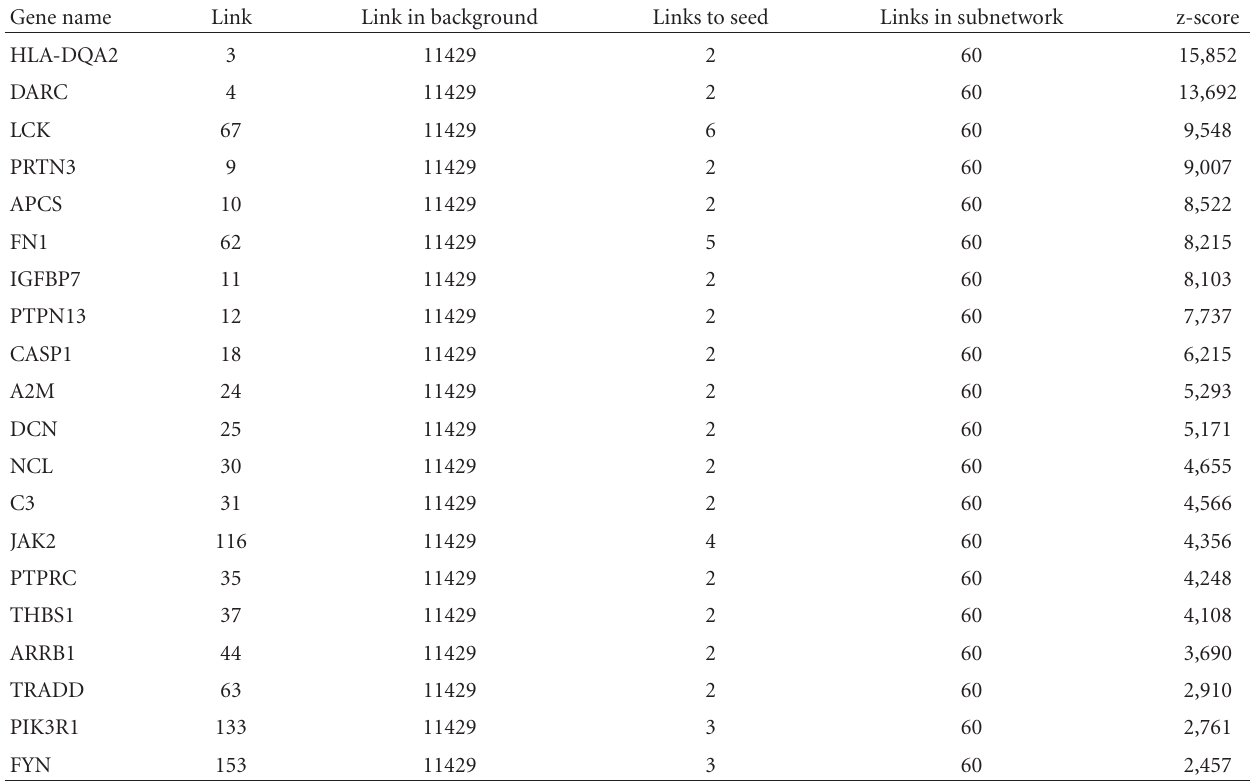
Figure 2: Clustering of seven autoimmune diseases. SLE: systemic lupus erithematosus, SS: Sj¨ogren’s syndrome, T1D: type 1 diabetes, AITD: autoimmune thyroid disease, RA: rheumatoid arthritis, MS: multiple sclerosis, SSc: systemic sclerosis. Table 4: Significance of intermediates sorted by